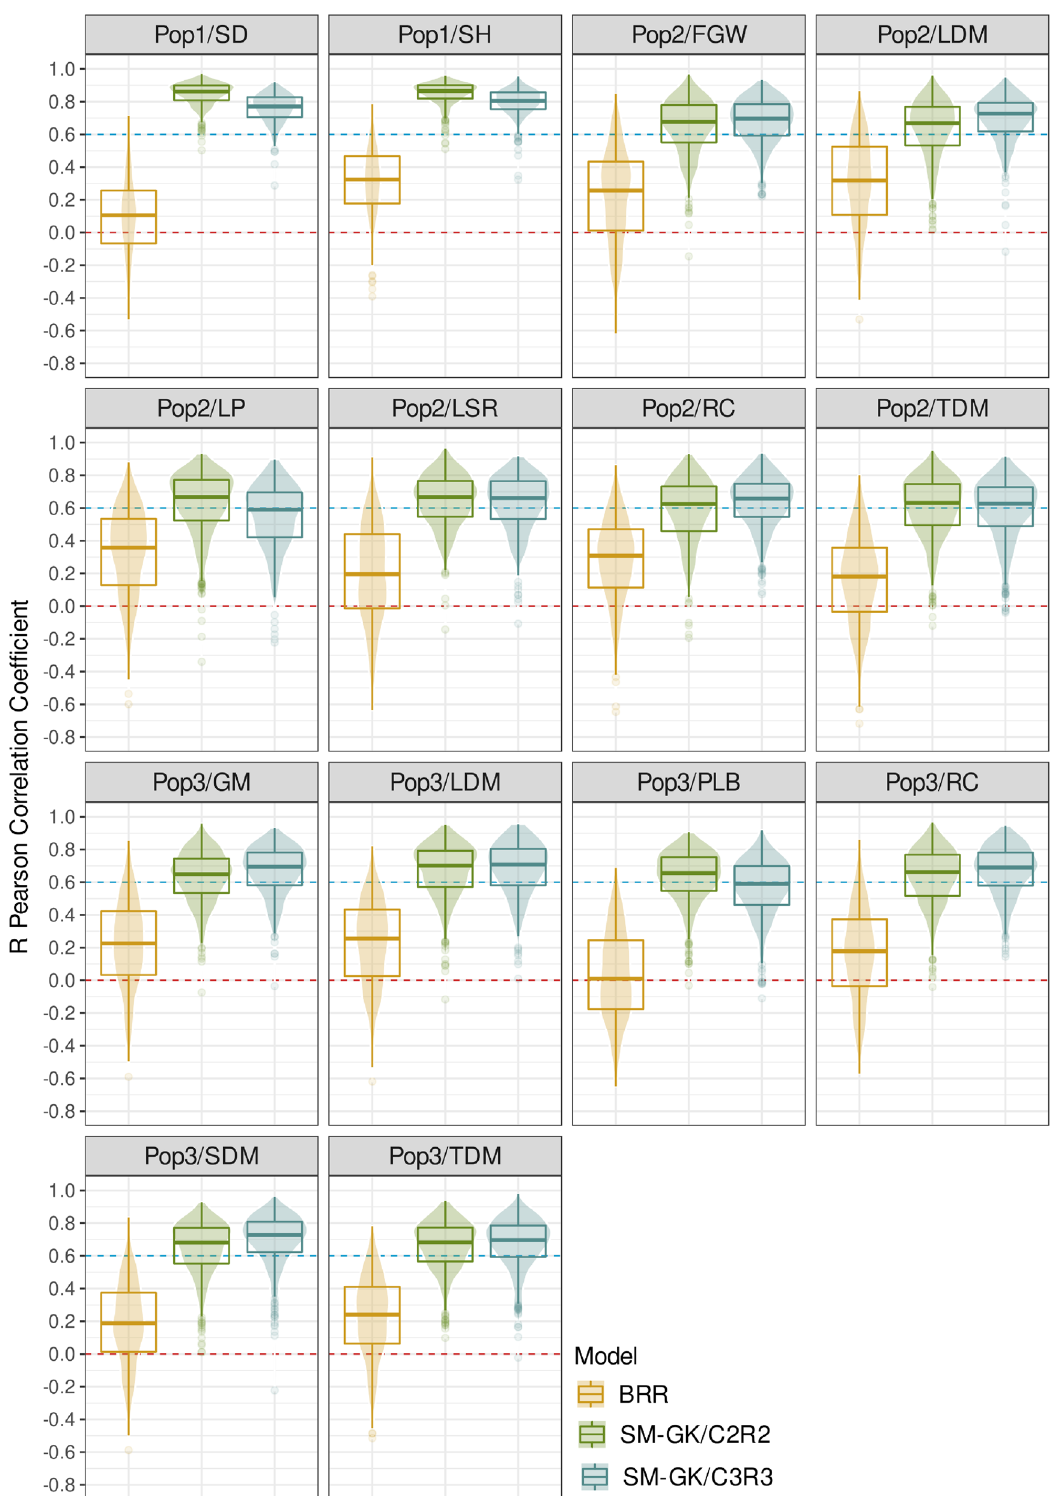
Figure 2. Genomic prediction models’ performances for the populations of (Pop1) sugarcane (stalk diameter (SD) and stalk height (SH)); (Pop2) Urochloa decumbens (field green weight (FGW), leaf dry matter (LDM), leaf percentage (LP), leaf stem ratio (LSR), regrowth capacity (RC), and total dry matter (TDM)); and (Pop3) Megathyrsus maximus (green matter (GM), LDM, percentage of leaf blade (PLB), RC, stem dry matter (SDM), and TDM). The Bayesian ridge regression (BRR) and single-environment main genotypic effect model with a Gaussian kernel (SM-GK) approaches with the inclusion of different feature selection methods (CR2 and CR3) were